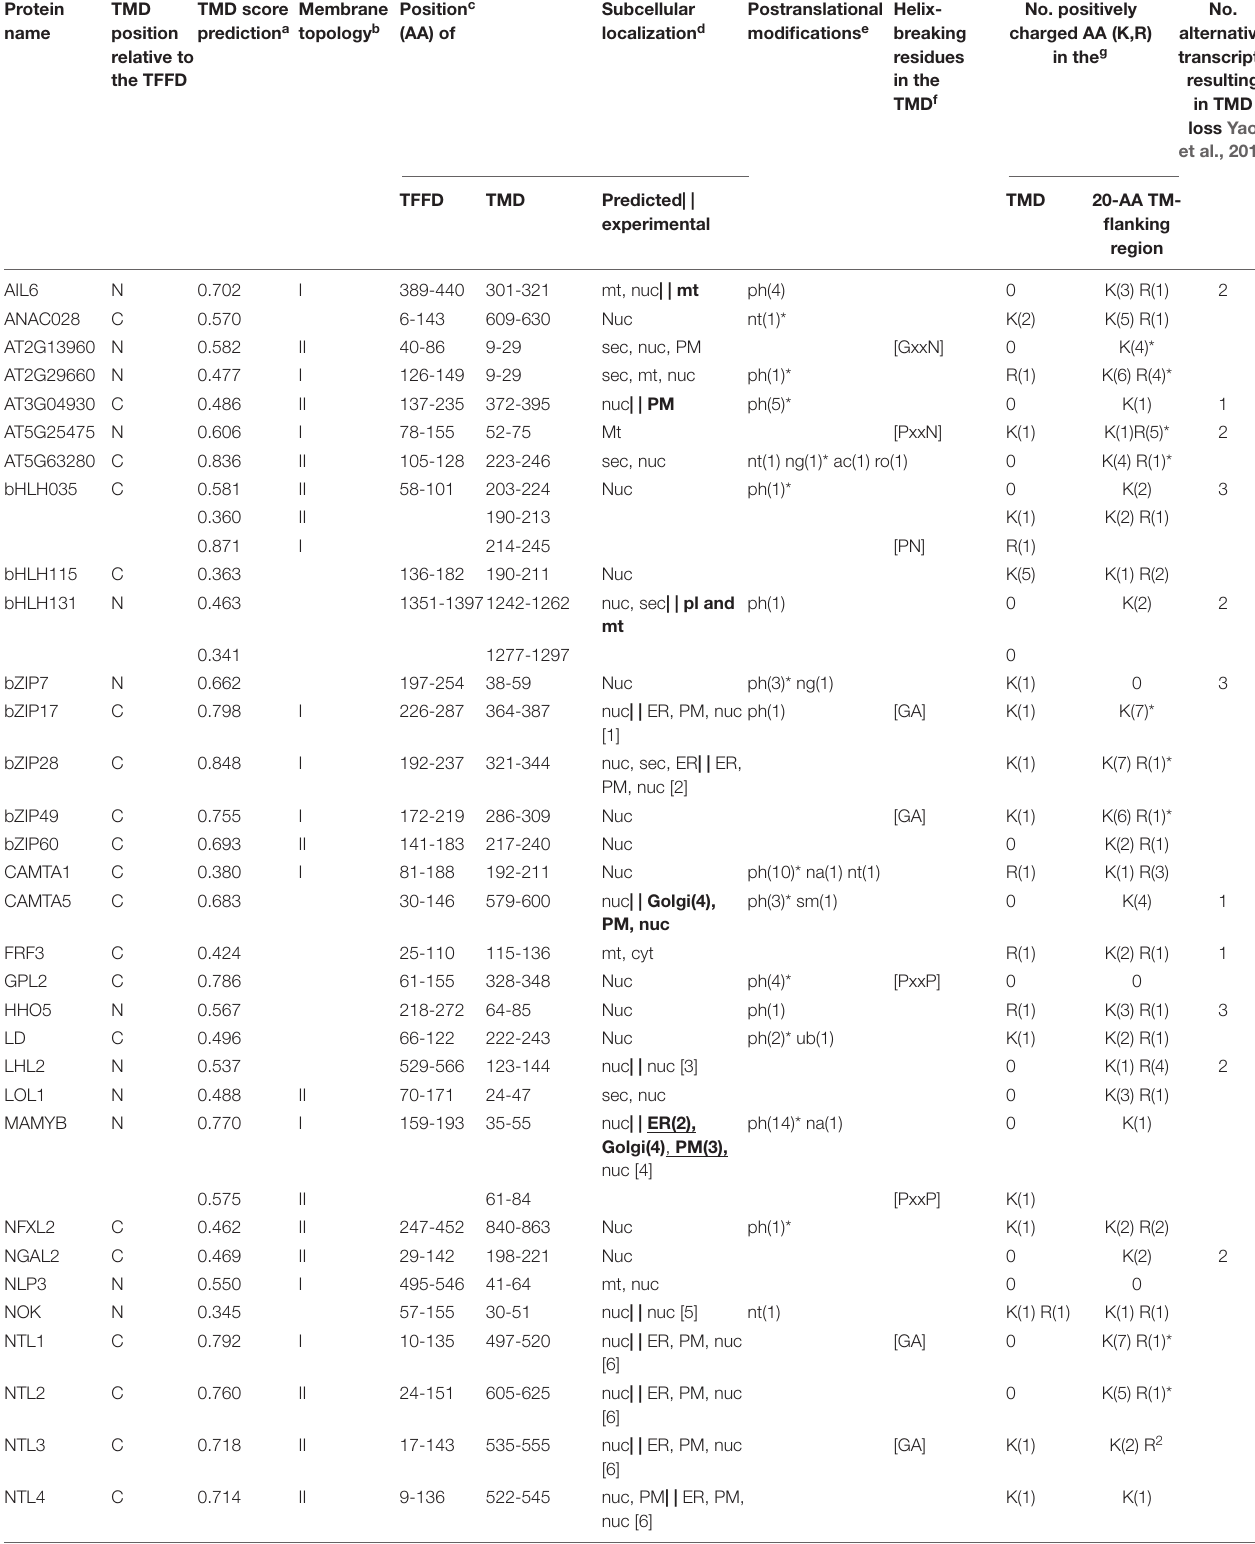
TABLE 1 | Overview of protein domain organization, membrane topology, subcellular localization, structural features indicative for regulated intramembrane proteolysis (RIP) and alternative transcripts of membrane-bound TFs in Arabidopsis (atMB-TFs). Protein